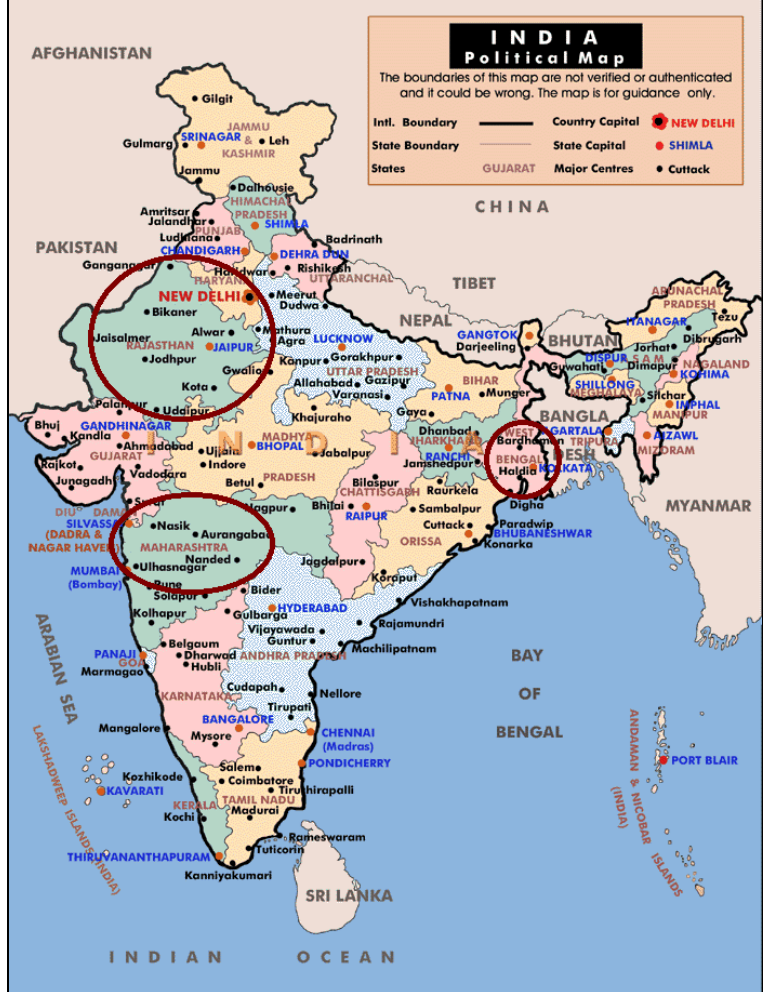
Figure 1. Study locations in India: Rajasthan, Maharashtra and West